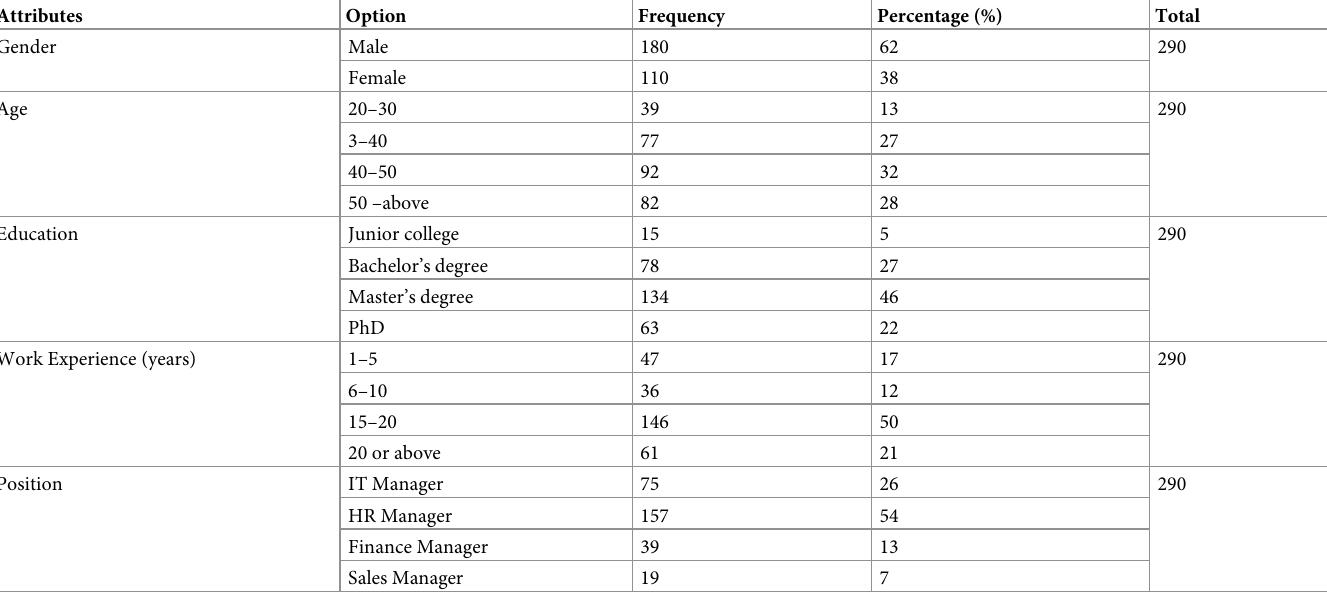
Table 1. Profile of